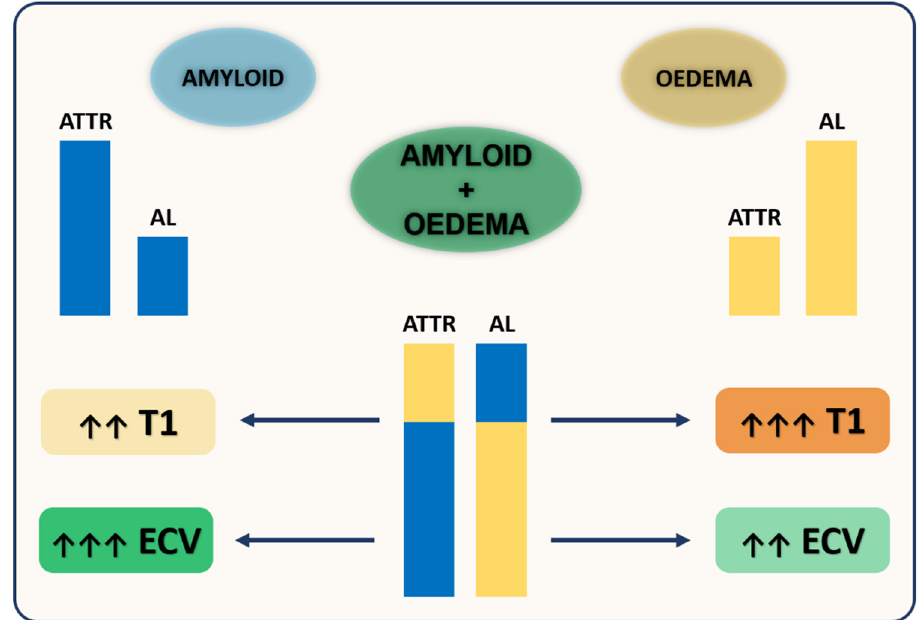
Figure 3. Different biological information provided by native T1 and ECV in Cardiac Amyloidosis (CA). Native myocardial T1 is highly influenced by water content in the tissue, thus significantly raised by oedema, at both intra- and extracellular level in amyloid light chains (AL) CA, or mostly at extracellular level in transthyretin (ATTR) CA. Conversely, ECV values are closely related to amyloid burden, and therefore are usually remarkably high in ATTR as compared to AL. This insight could explain the relatively higher T1 values in AL compared to ATTR, along with the higher ECV values in ATTR compared to AL.